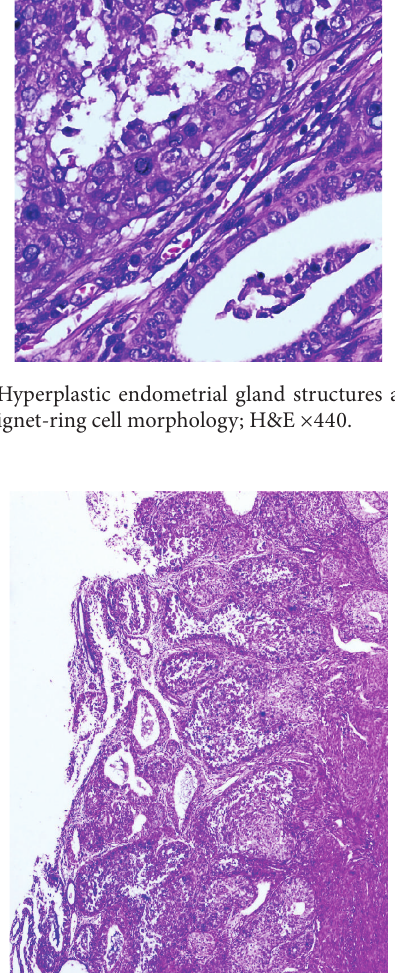
Figure 4: Superficial tumoral invasion; H&E × 110.